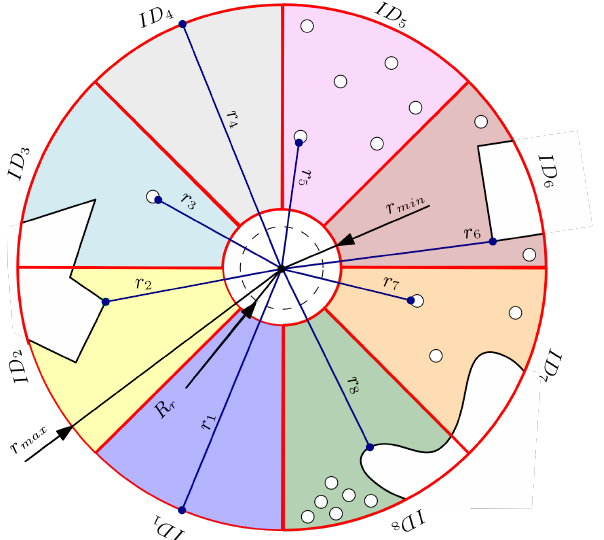
Figure 4. Schematic view of the chunking principle of the field of view of the robot. In this example the area is split into eight sections: for each section the distance from the closest obstacle/pedestrian is